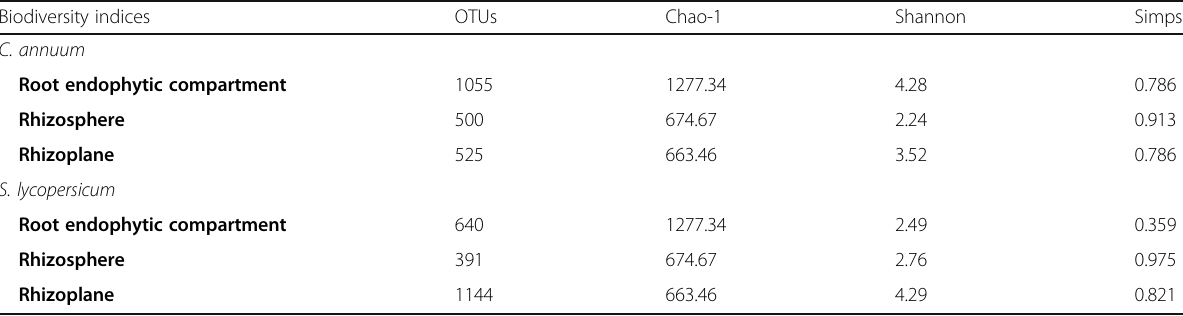
Table 2 Alpha-diversity indices of bacterial communities across the different samples Biodiversity indices OTUs Chao-1 Shannon